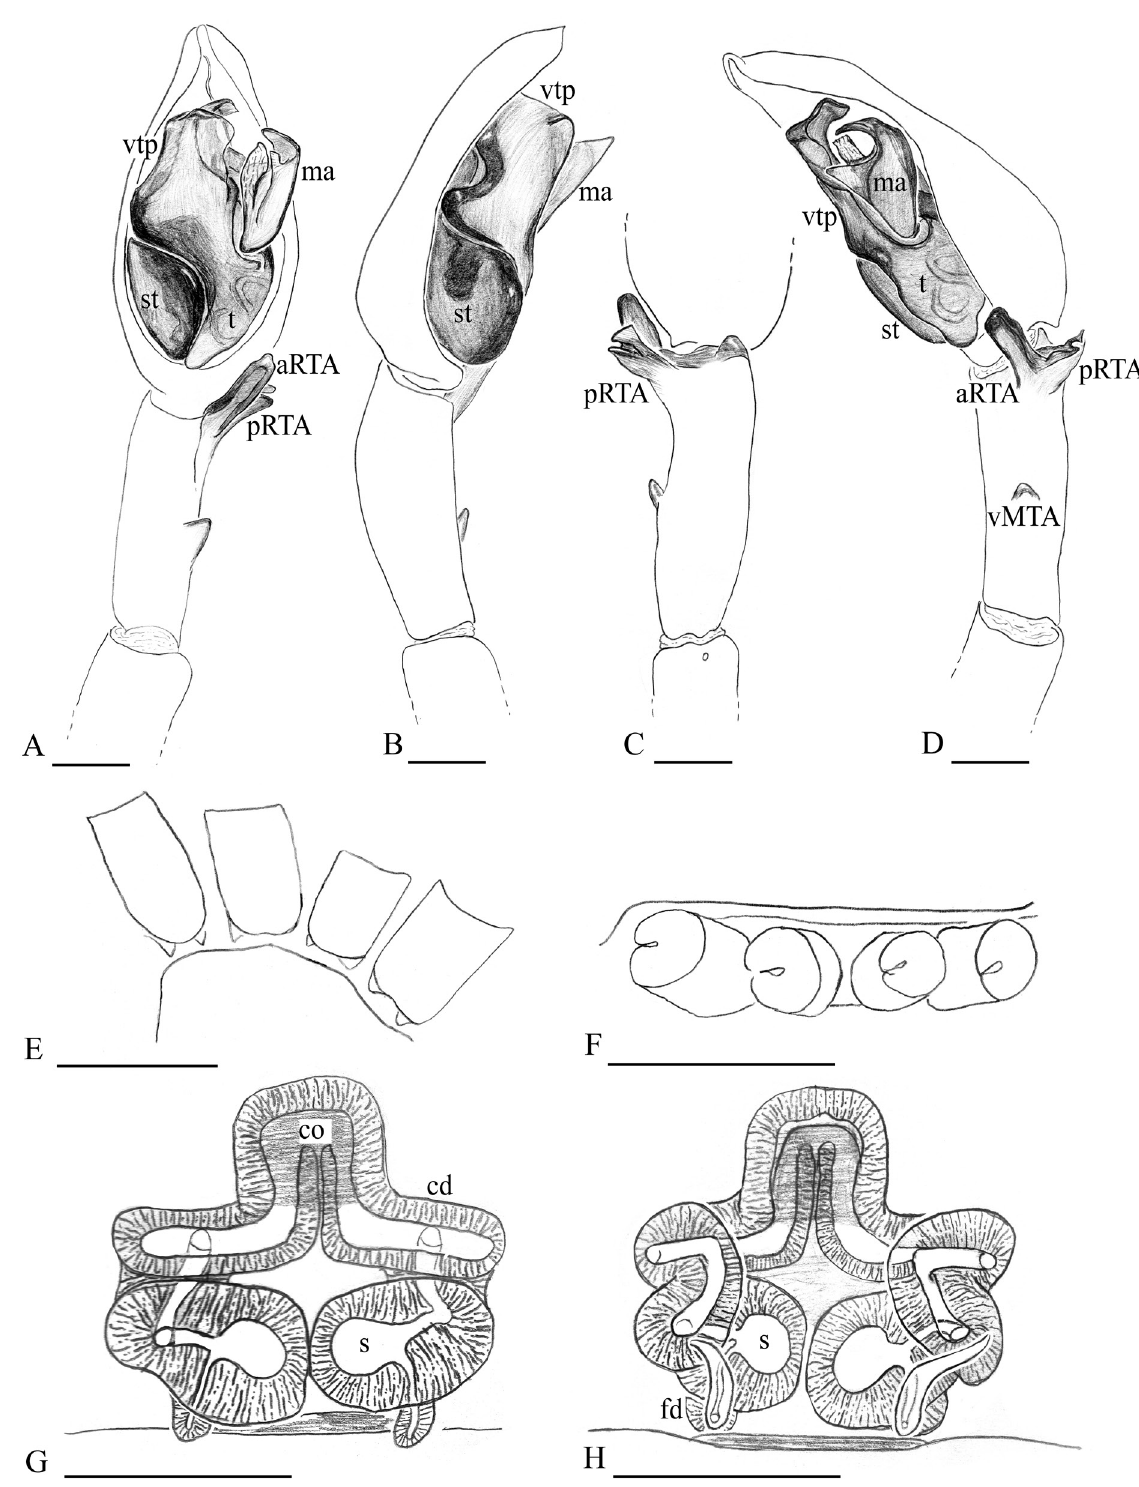
Fig. 47. Anyphaena tonoi sp. nov. A–F . Paratype, ♂ (CNAN-T01575). G–H . Paratype, ♀ (CNAN-T01576). A . Pedipalp, ventral view. B . Pedipalp, prolateral view. C . Pedipalp, dorsal view. D . Pedipalp, retrolateral view. E . Coxae, ventral view. F . Coxae, lateral view. G . Epigynum, ventral view. H . Epigynum, dorsal view. Scale bars: A–D, G–H = 0.2 mm; E–F = 1.0